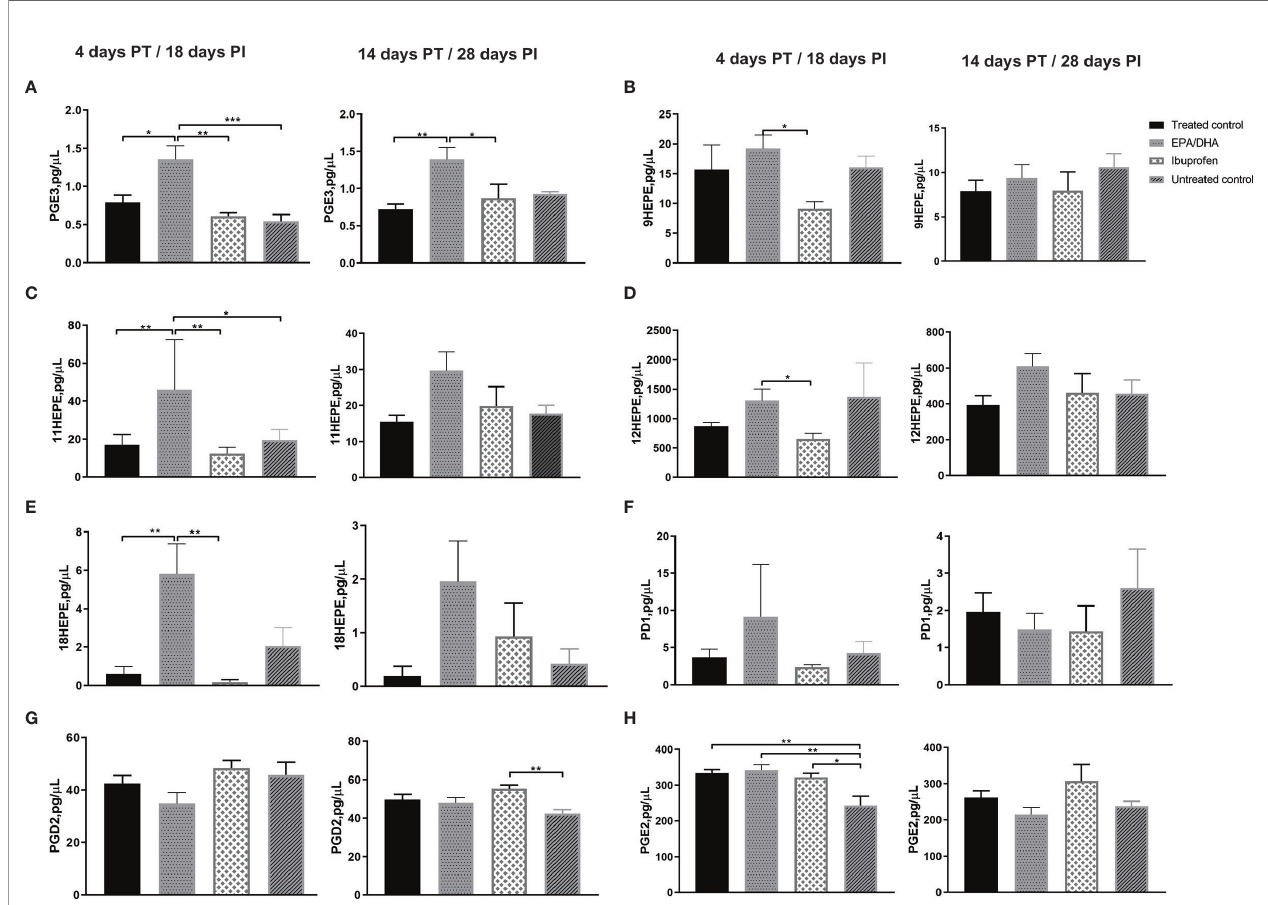
FIGURE 4 | Treatment effects of lipid mediators in crude lung homogenate at the local site of intervention. (A) PGE3, (B) 9-HEPE, (C) 11-HEPE, (D) 12-HEPE, (E) 18-HEPE, (F) PD1, (G) PGD2 and (H) PGE2. All data are presented in pg/µL. All mice, except untreated controls, were on standard TB antibiotics Rifafour ® for 4 days of treatment, then rifampicin and isoniazid (RH) for 10 days. All values represent mean ± SEM. Results repeated in two experiments, data shown for one experiment (n=6 per group). One-way ANOVA followed by Tukey ’ s post-hoc test was used to compare means, *P < 0.05, **P < 0.01 and ***P < 0.001. EPA, eicosapentaenoic acid; DHA, docosahexaenoic acid; HEPE, hydroxyeicosapentaenoic acid; PGD2, prostaglandin D2; PGE3, Prostaglandin E3; PD1, Protectin D1 and PGE 2 , prostaglandin E 2 ; PT, post treatment; PI, post